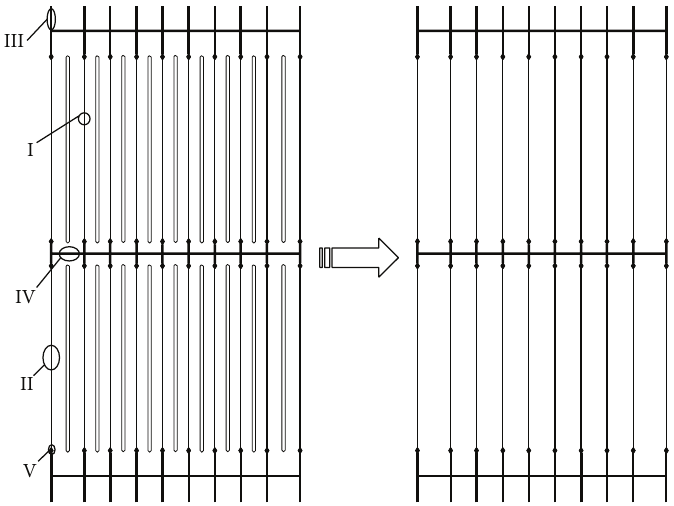
Figure 12: Wall-frame analysis model of the steel slit wall.